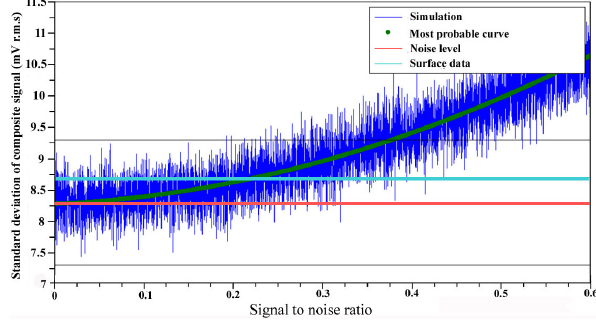
Fig. 10. Distribution of mean value µ of the composite bin 36 versus SNR derived from 10000 runs of simulation S2. The most likely value (SNR ∼ 0.35) lies at the intersection between the green curve and the bright blue line.